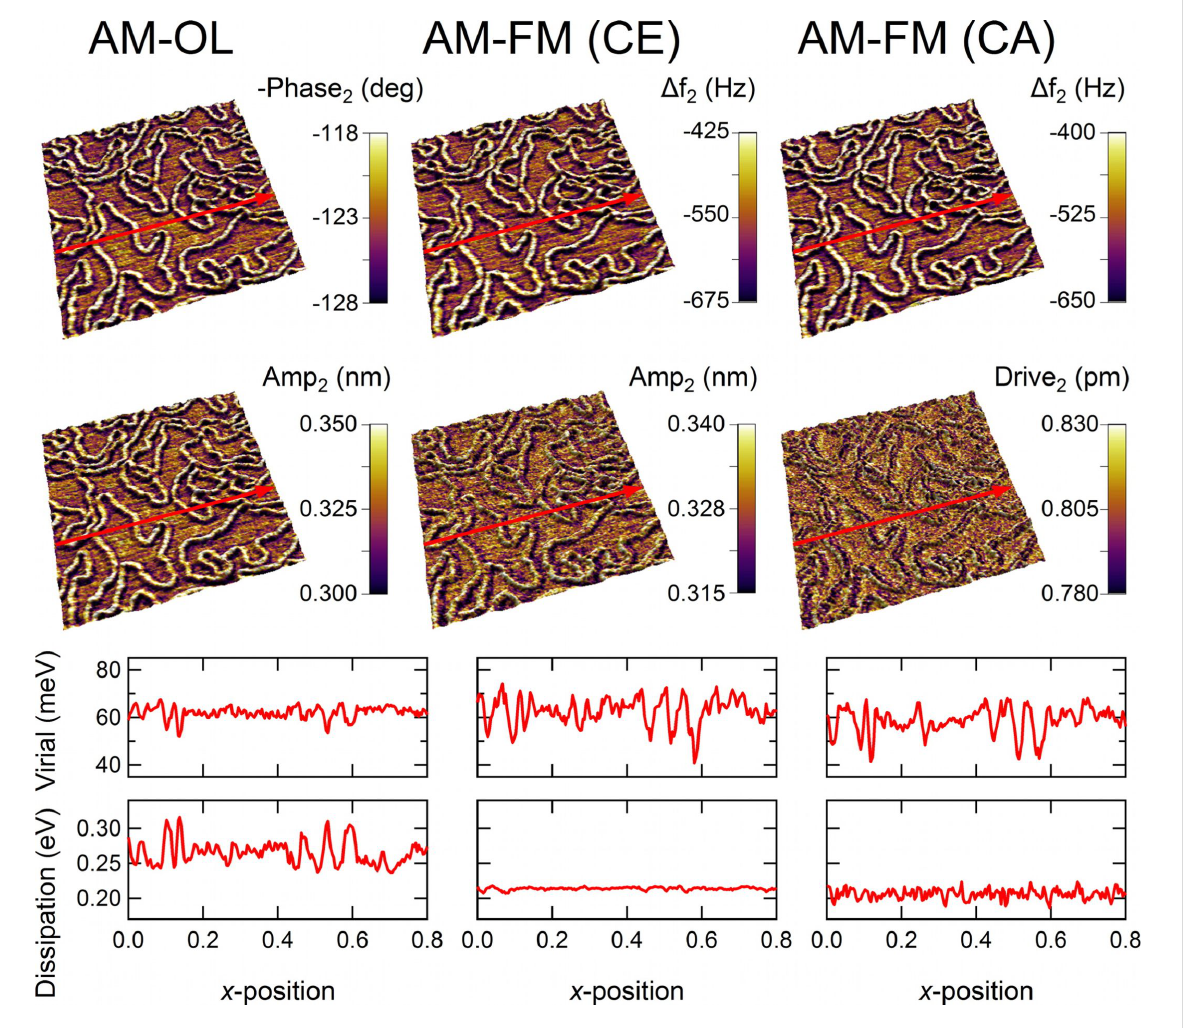
Figure 3: Comparison of 2nd eigenmode contrasts for different operation modes (left: AM-OL, middle: AM-FM (CE), right: AM-FM (CA). The two top rows show 3D topography images (800 × 800 nm 2 ) of lambda DNA strands adsorbed onto a mica substrate. For each operation mode the topog- raphy images are overlaid by their corresponding 2nd eigenmode signal channels, which are phase shift (inverted) and oscillation amplitude (AM-OL), frequency shift and oscillation amplitude (AM-FM (CE)), or frequency shift and drive amplitude (AM-FM (CA)). In the two bottom rows the virial and energy dissipation for the scan line indicated are depicted. Parameters: rectangular silicon cantilever (PPP-NCSTAuD, Nanosensors), f 1 = 92.4 kHz, k 1 = 2.0 N/m, Q 1 = 208, f 2 = 586.8 kHz, k 2 = 97.6 N/m, Q 2 =